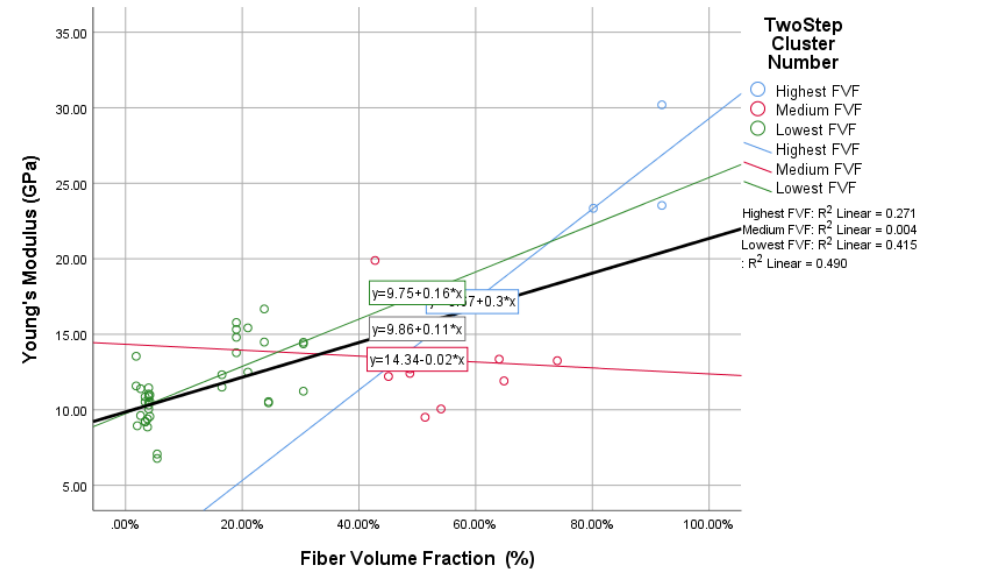
Figure 11. The relationship between fiber volume fraction and Young’s modulus.